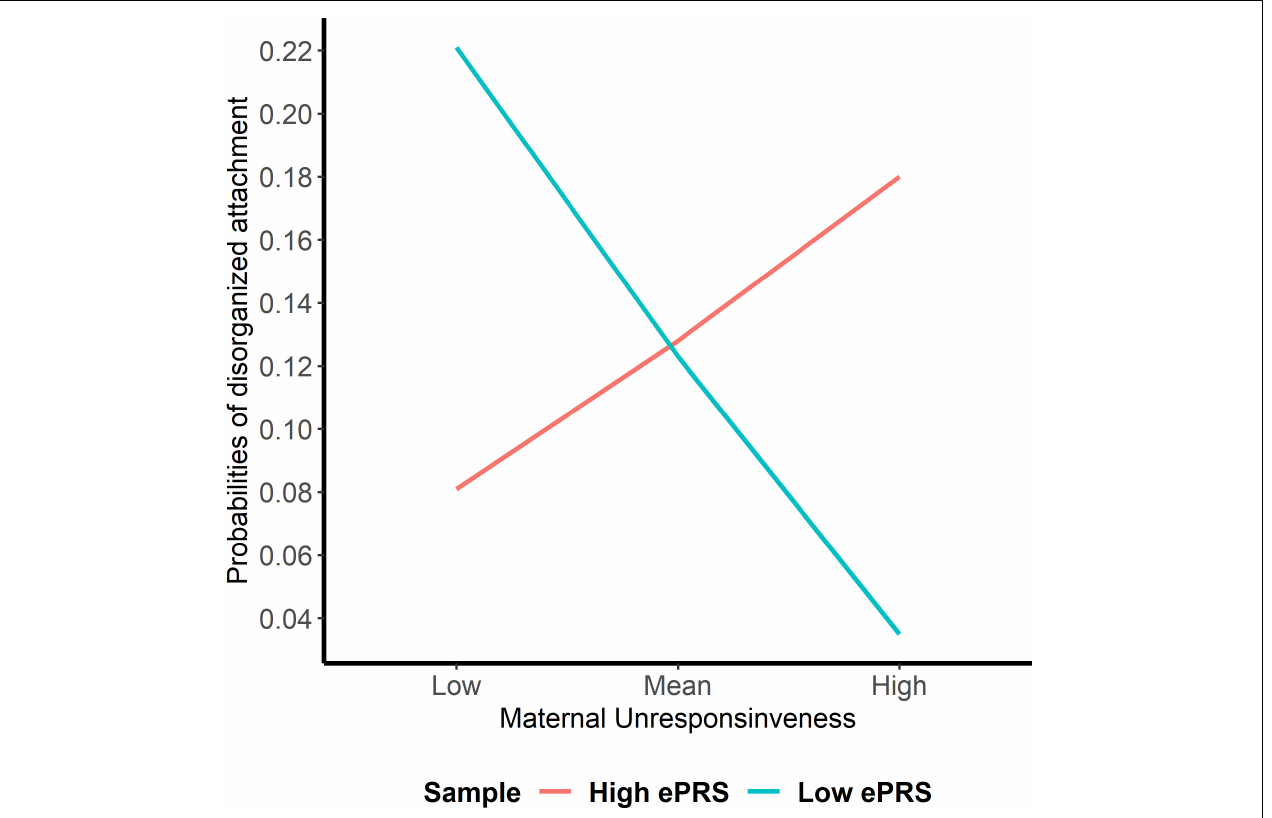
FIGURE 6 | Interaction between Hippocampal Gene Network and Maternal Unresponsiveness in Disorganized Attachment. Shows that high maternal unresponsiveness and a low CNR1 ePRS in the hippocampus predict a lower probability of disorganization. Higher maternal unresponsiveness and a high CNR1 ePRS in the hippocampus predict a higher probability of